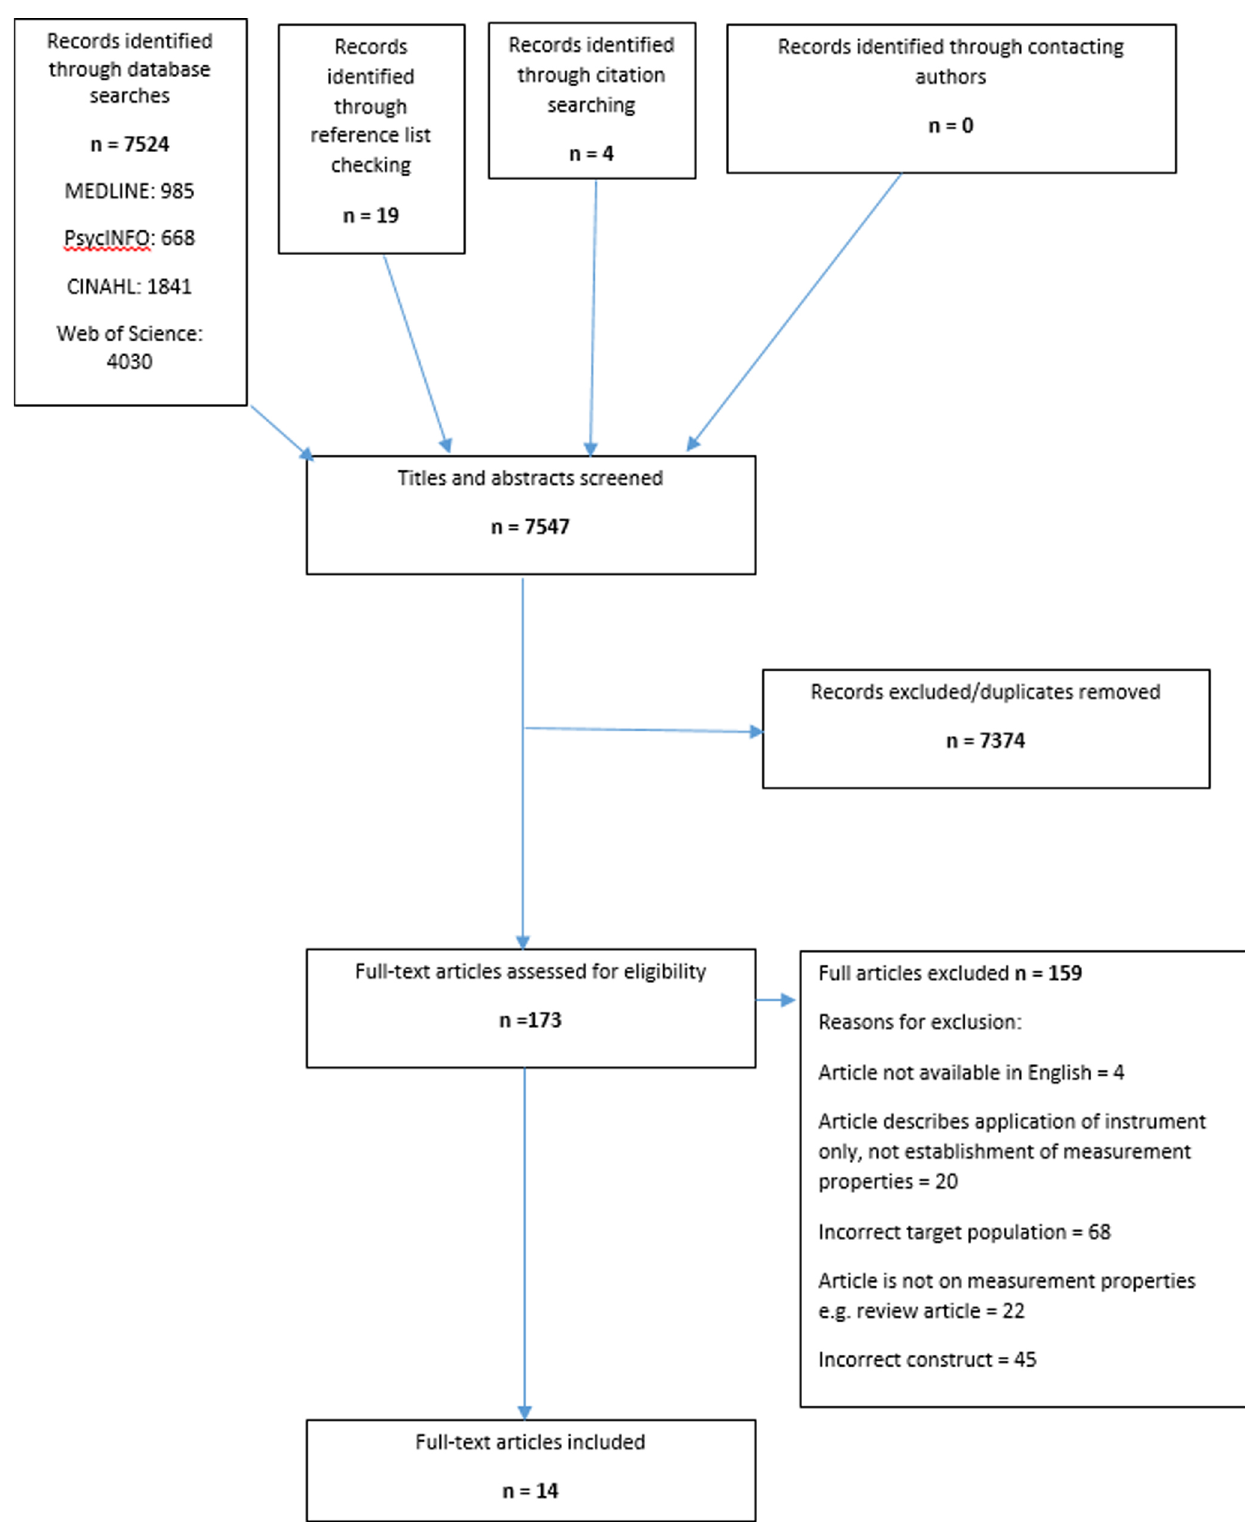
Fig 1. Results of literature search.